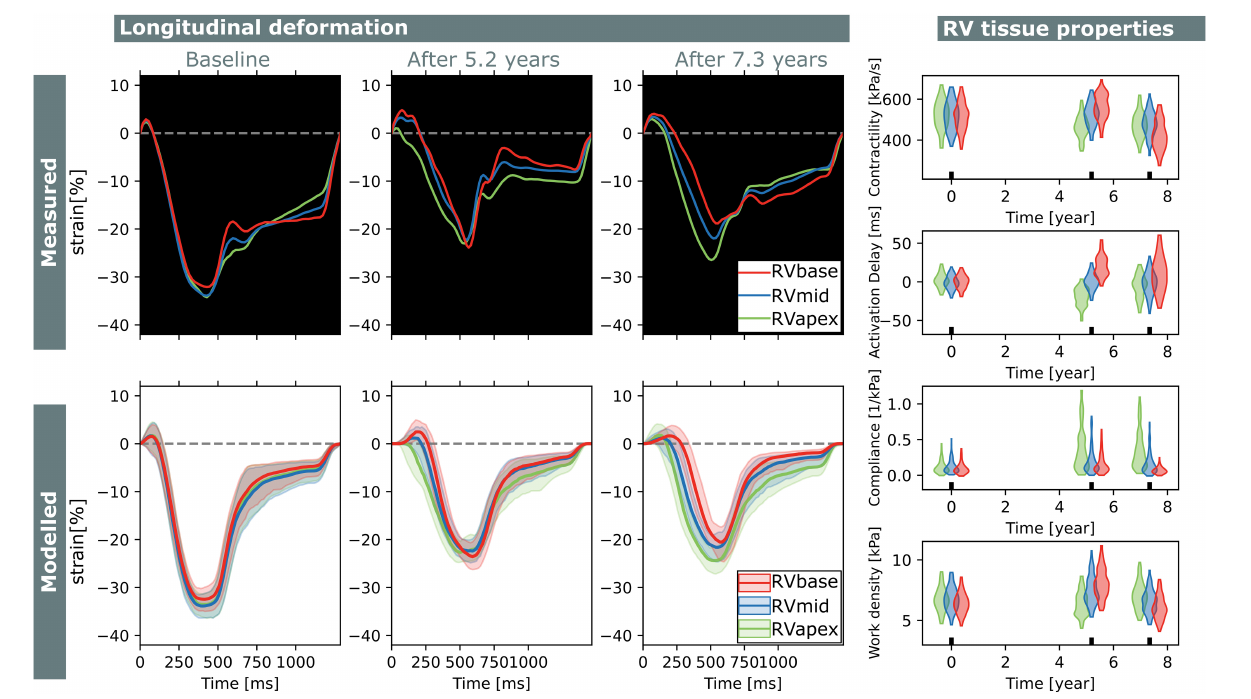
FIGURE 8 | Longitudinal estimations subject 2. Echocardiographic deformation imaging was performed at baseline, and after 5.2 and 7.3 years of follow-up. Subject 2 had normal RV deformation patterns at baseline and did not develop clear deformation abnormalities during follow-up. Contractility, compliance, and work density were estimated homogeneously at